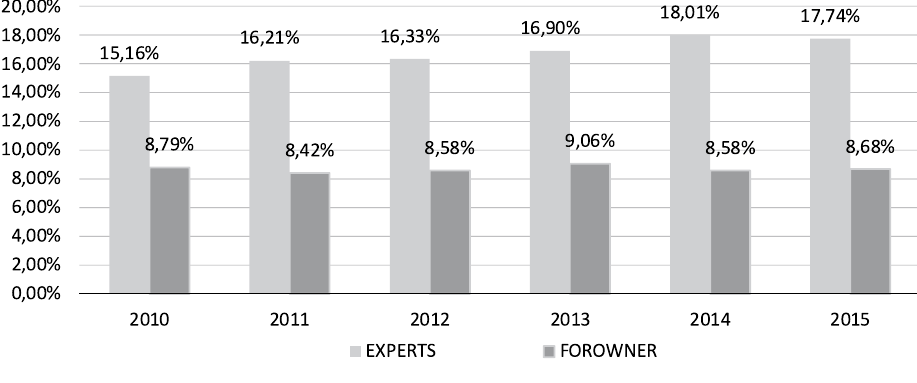
Figure 3. The Share of International Experts and the Share of Foreign